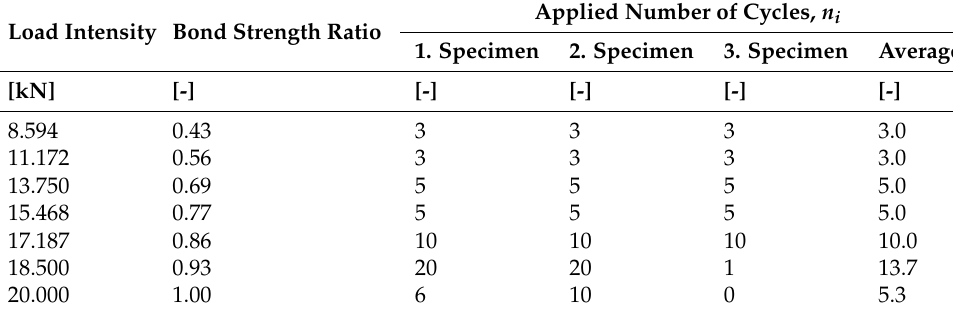
Table 5. Maximum number of cycles at a given load level.